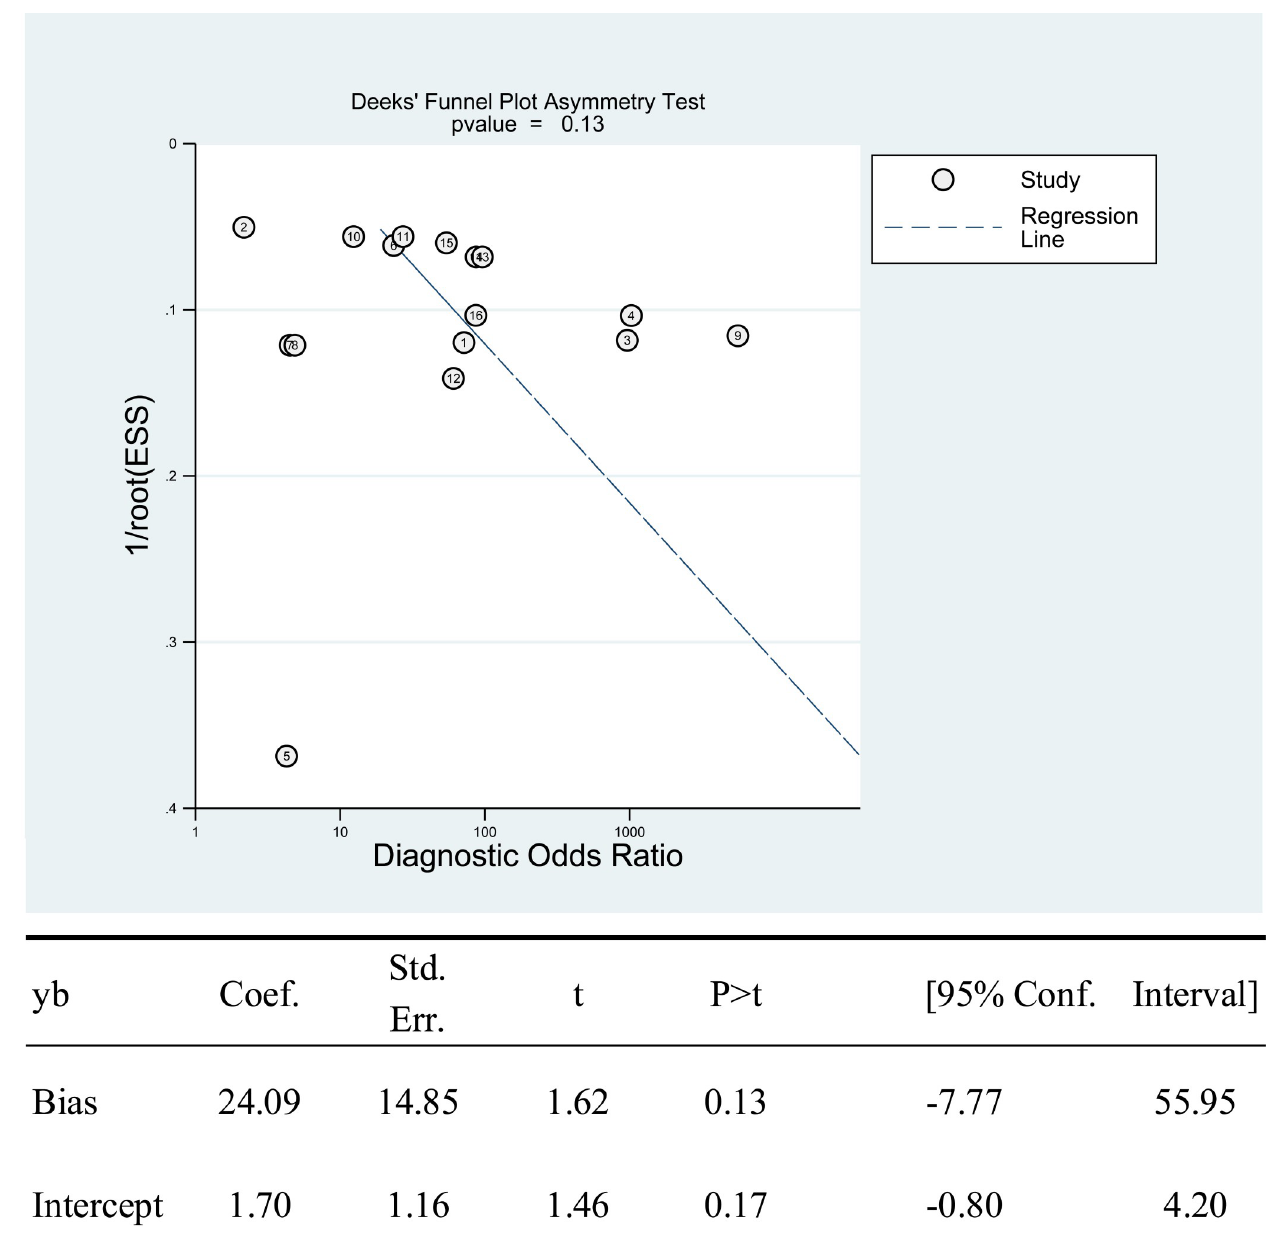
Fig 4. Assessment of publication bias by Deek’s funnel plot asymmetry